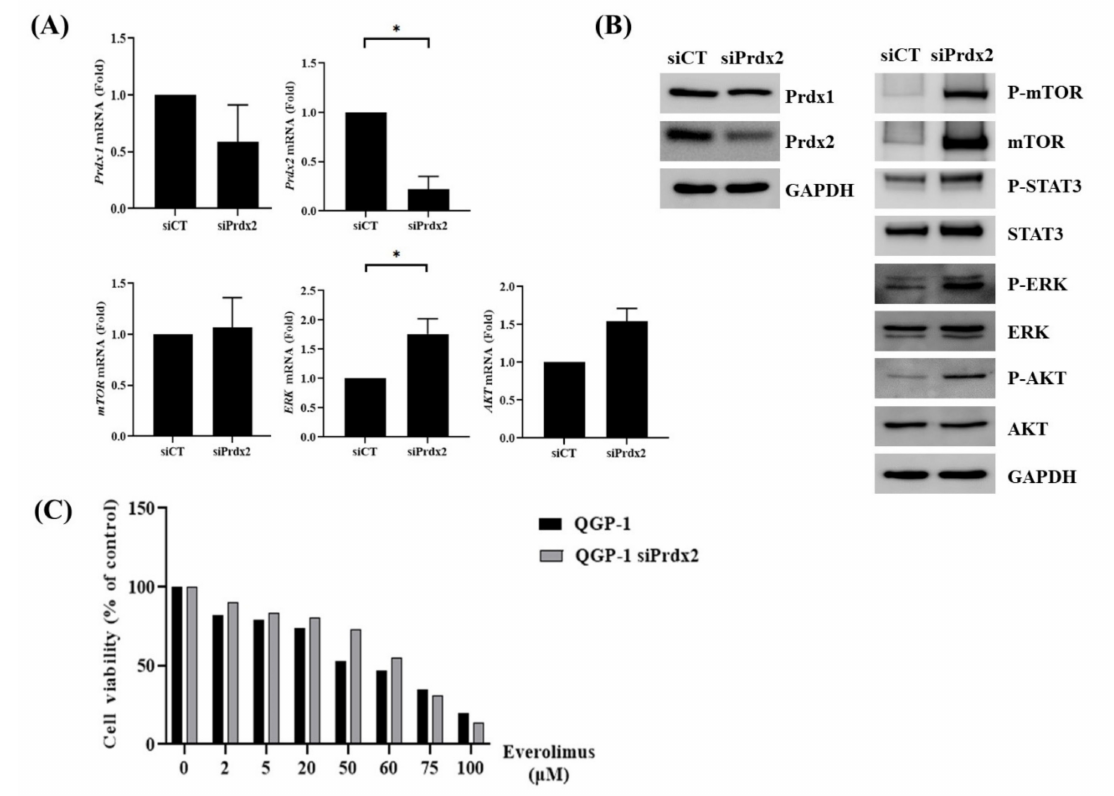
Figure 3. E ff ect of Prdx2 knockdown on QGP-1 cells. ( A ) The mRNA level of Prdx2 was downregulated, and that of ERK was upregulated, in siPrdx2 QGP-1 cells; ( B ) Western blotting showed that downregulation of Prdx2 was achieved partially, but the level of mTOR, phosphorylated mTOR, phosphorylated ERK, and phosphorylated AKT were increased in siPrdx2 QGP-1; ( C ) MTT assay showed that the antitumor e ff ect of everolimus was significantly lower in siPrdx2 QGP-1 cells than in the negative control cells. * p <